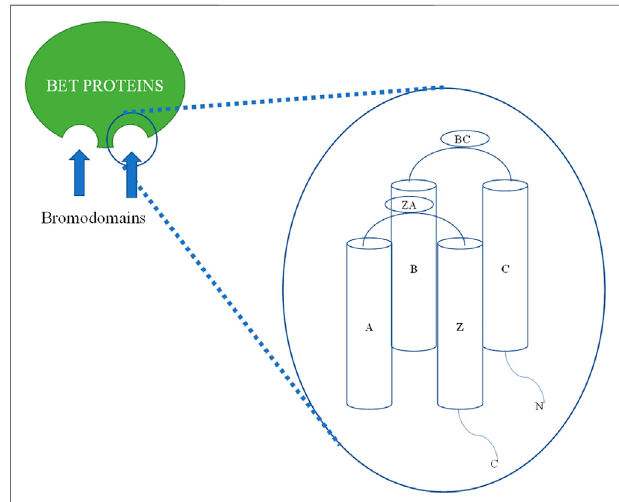
FIGURE 2 | Two-dimensional (2D) structural diagram of BET bromodomain (BRD2, BRD3, and BRD4) proteins: All BET bromodomain proteins have common four alpha-helical bundles named as α Z, α A, α B, and α C. α B and α Care connectedby aBCloop, and a ZAloop connects α Z, α A helices (based on x-ray crystal